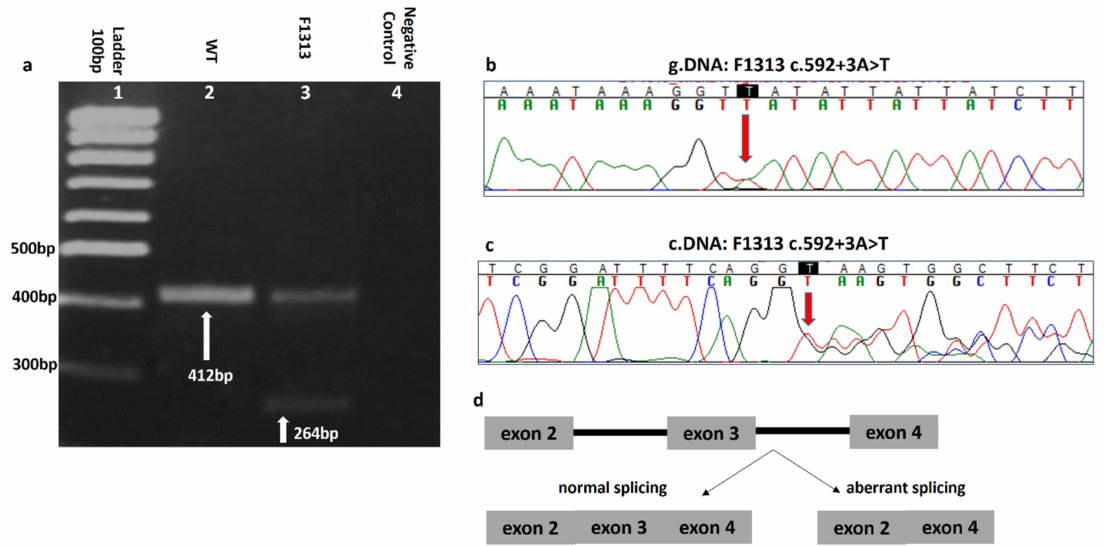
Figure 2. RNA analysis of the CHEK2, c.592+3A>T pathogenic variant. ( a ) cDNA products visualized on an agarose gel, where the 412 bp and 264 bp bands correspond to wild-type and mutant allele, respectively, ( b ) Electropherogram of genomic DNA and ( c ) cDNA from the carrier patient, F1313, performed by Sanger sequencing and ( d ) schematic representation of the skipping